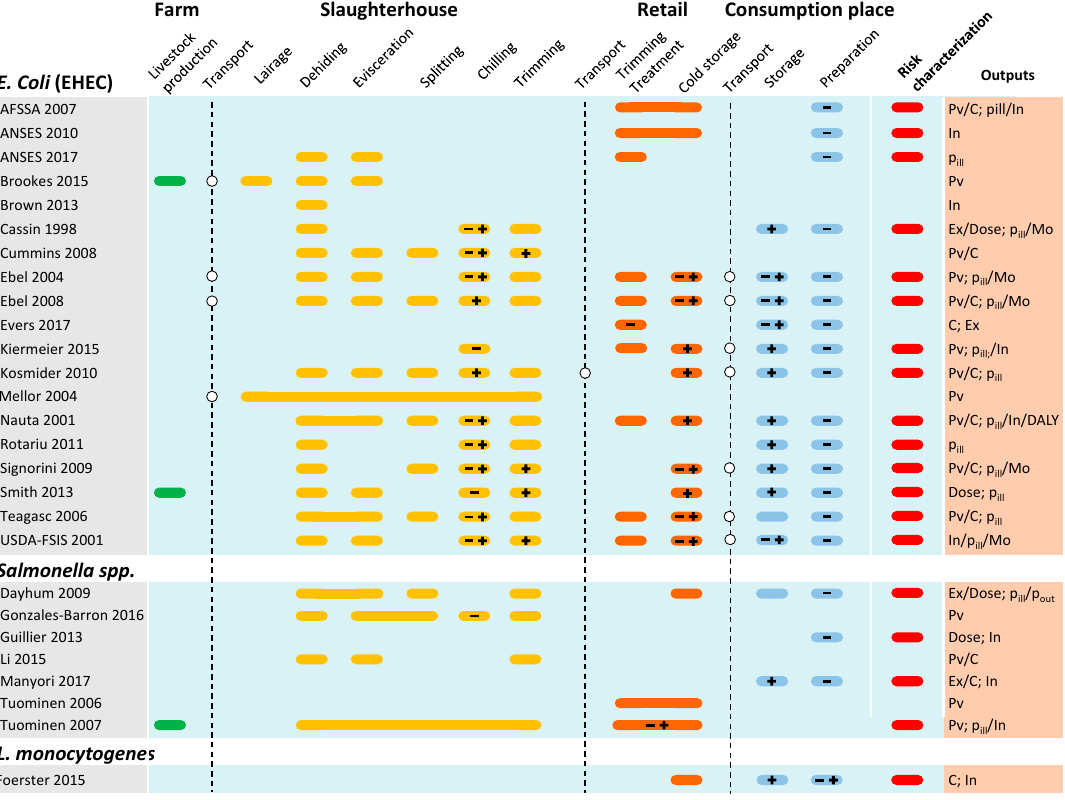
Figure 4. Meat chain steps considered in collected beef QMRAs for Enterohemorrhagic E. coli (EHEC), Salmonella spp., and Listeria monocytogenes ( − : bacterial reduction accounted, +: bacterial growth accounted; Ex : exposure; Pv: prevalence; C : count and/or concentration; p ill : probability of illness; p out : probability of outbreak; Mo: mortality; DALY : disability-adjusted life year expectancy).